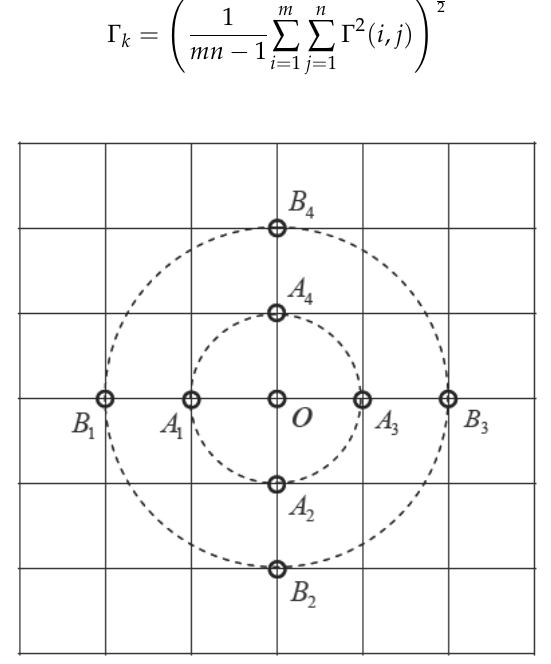
Figure 2. Principal schematic view of new characteristic parameters.